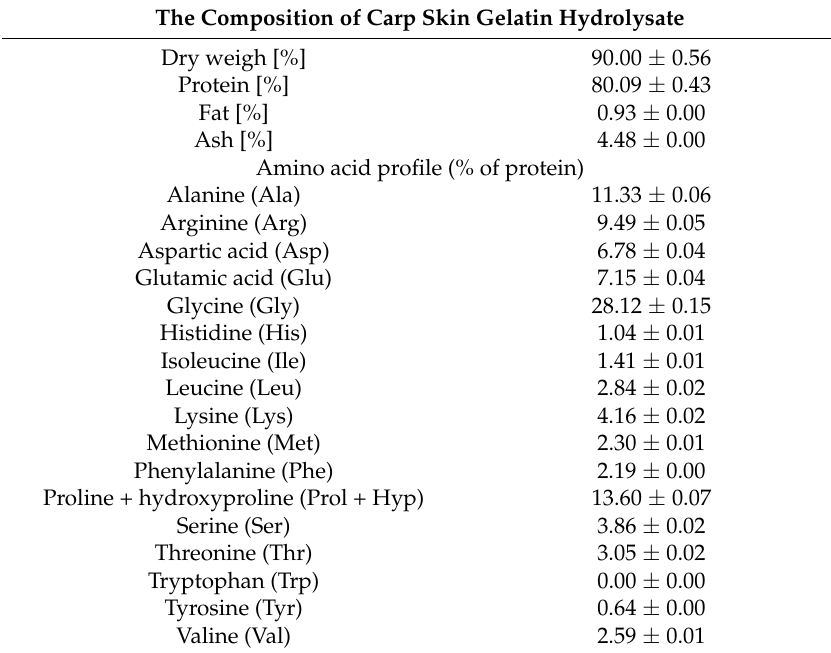
Table 1. The composition and amino acid profile of the hydrolysate of carp skin gelatin. The Composition of Carp Skin Gelatin